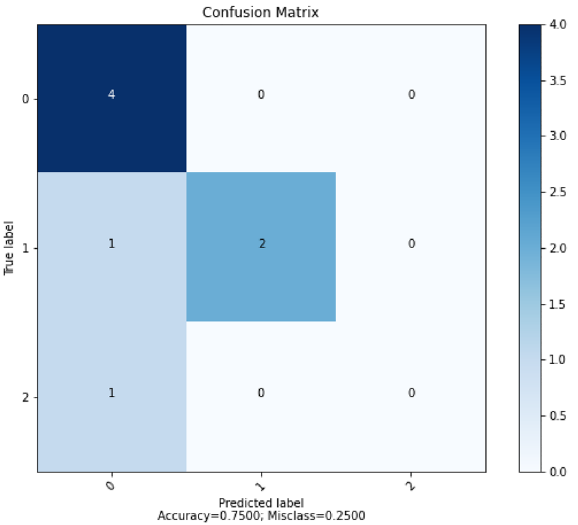
Figure 14. Confusion matrix for